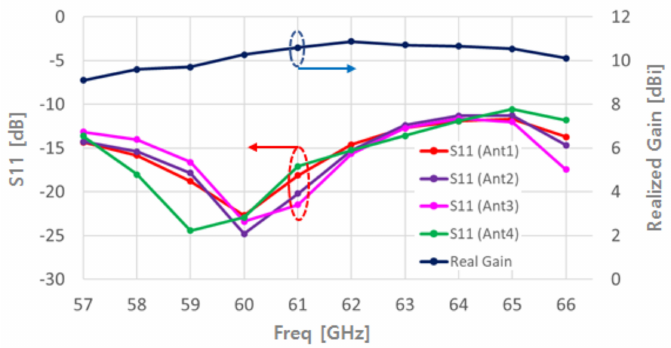
Figure 8. Return loss and antenna gain of the 2 × 2